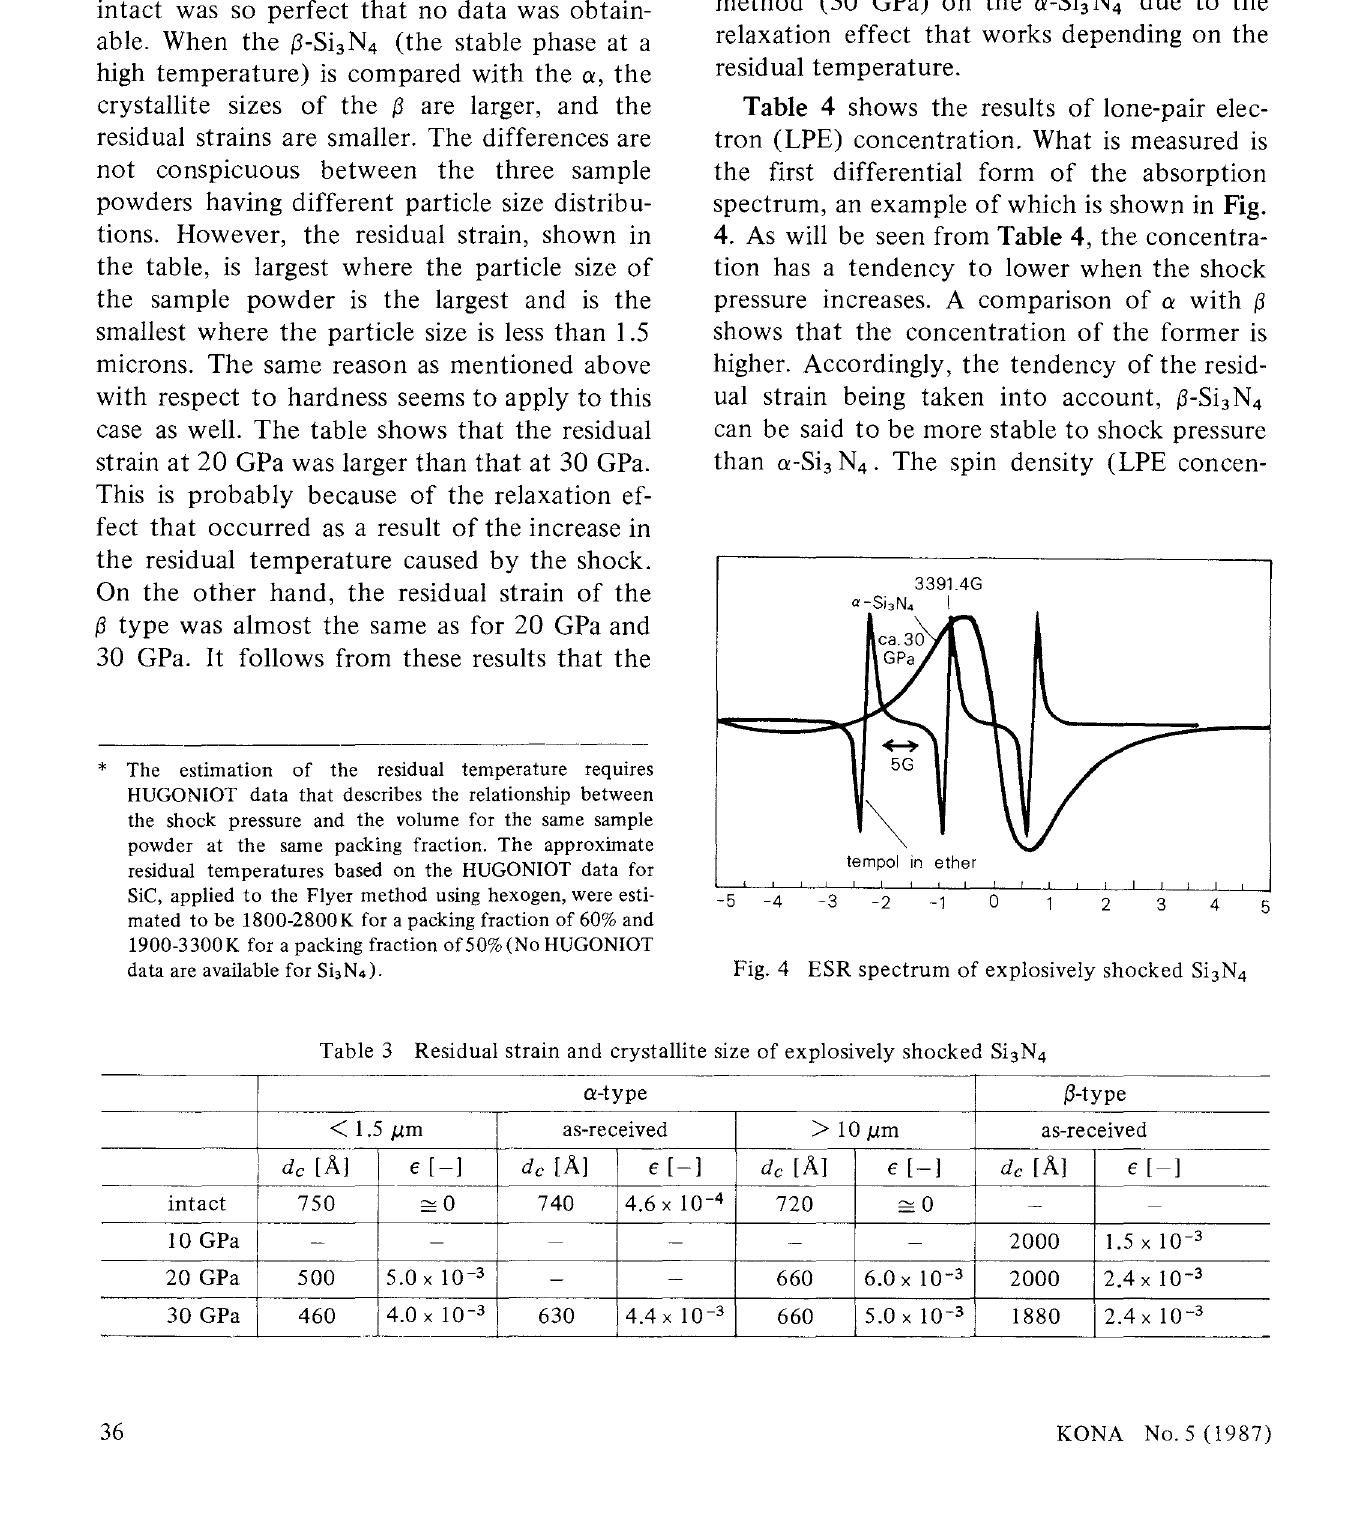
Table 3 Residual strain and crystallite size of explosively shocked Si 3 N 4 a-type {3-type < 1.5